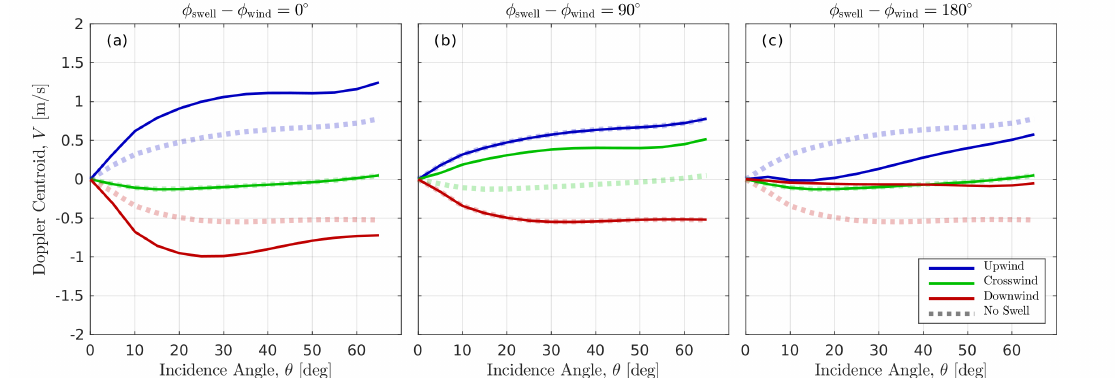
Figure 12. KaDOP simulation, Equation (16), at U = 6 m/s for (dotted lines) pure wind sea without swell and (solid lines) mixed sea with ( a ) downwind swell, ( b ) crosswind swell, and ( c ) upwind swell. Swell parameters are λ sw = 600 m, T sw = 20 s, ( AK ) sw = 0.05, A sw = 5